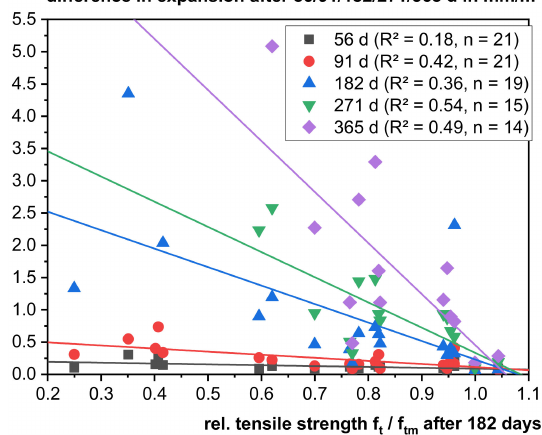
Figure 3. Correlation of the difference in expansion (SVA method, 3000 mg SO 42 − /L, 5 ◦ C) over the course of time (see colored markers and lines) and the relative tensile strength f t /f tm after 182